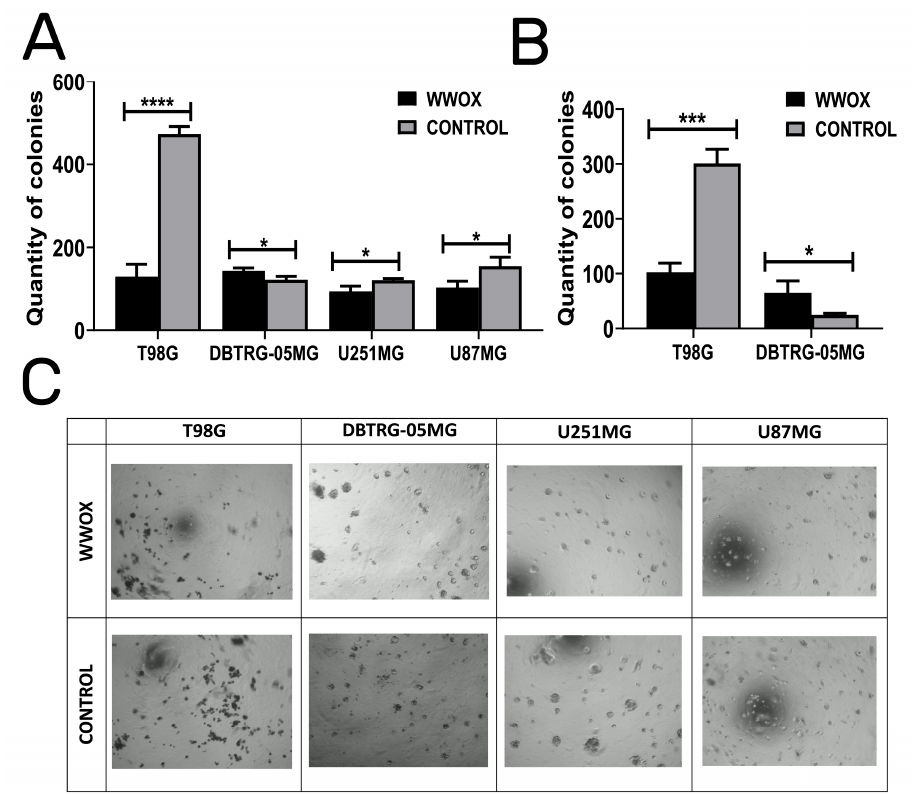
Figure 4. Observation of changes in the number of colonies and their anchorage-independent or three-dimensional growth. ( A ) Clonogenicity. ( B ) Anchorage-independent growth. ( C ) Three-dimensional culture in Geltrex. p < 0.05 (*), p < 0.001 (***), p < 0.0001 (****).